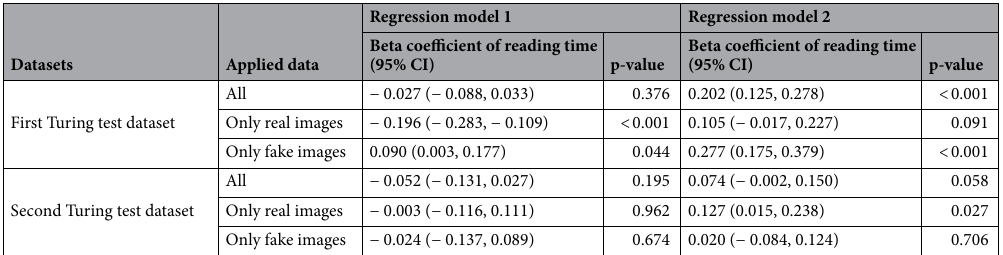
Table 4. Mixed effect logistic regression model for reading time in the image Turing test. Regression model 1: log(reading time + 1) ~ correct (y/n) + image random effect + reader random effect. Regression model 2: log(reading time + 1) ~ correct (y/n) + image random